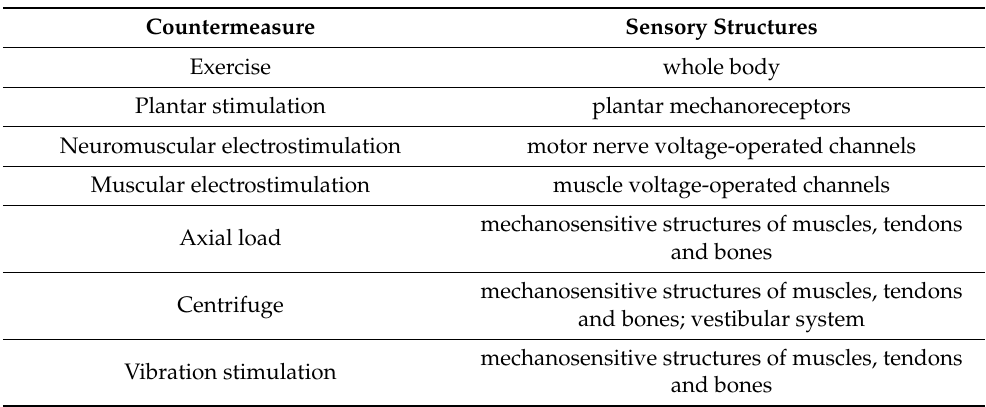
Table 2. Main countermeasure methods used to prevent unloading-induced muscle alterations, and the sensory structures that respond to